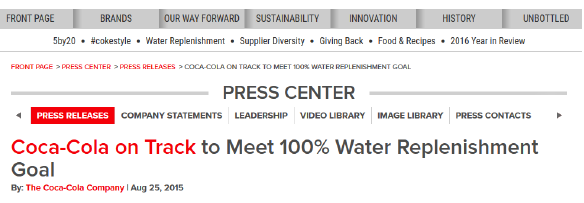
Figure 2. Screenshot of an online press release from 25 Au- gust 2015 (Coca Cola Company, 2015). In this press release, the Coca Cola Company claims to be close to “water neutral”. For this purpose, water use related to the production process is offset (“re- plenished”) by conservation efforts around the globe. The press re- lease was quickly and mostly uncritically picked up by various me- dia channels, e.g. the New York Times online edition.